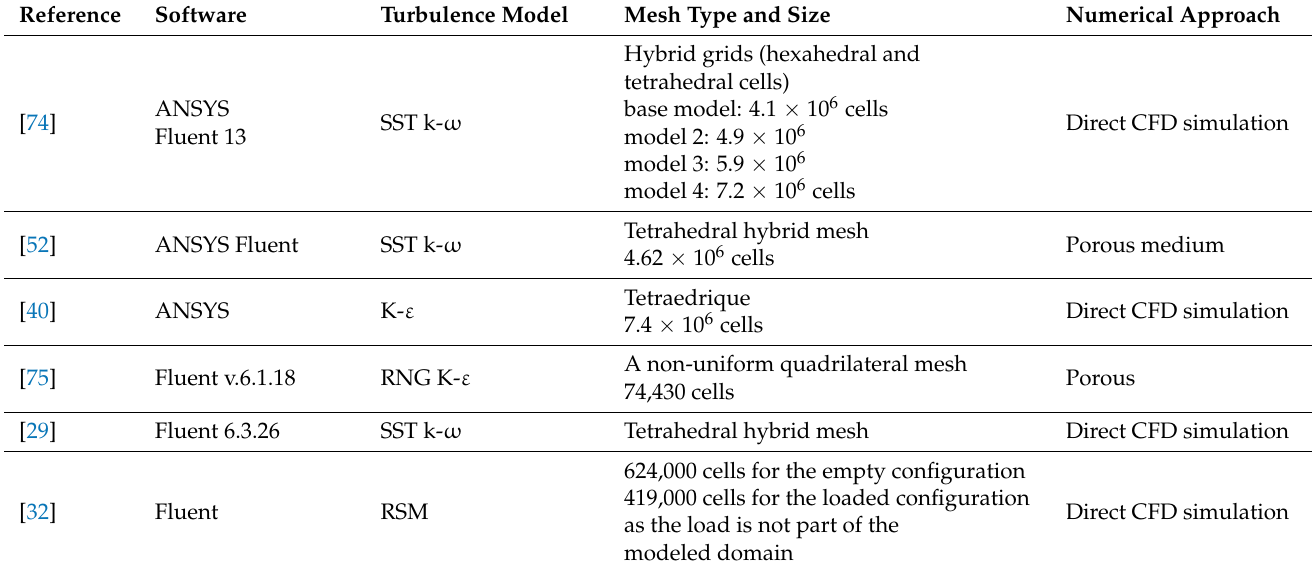
Table 1. Studies applying different numerical approaches and turbulence